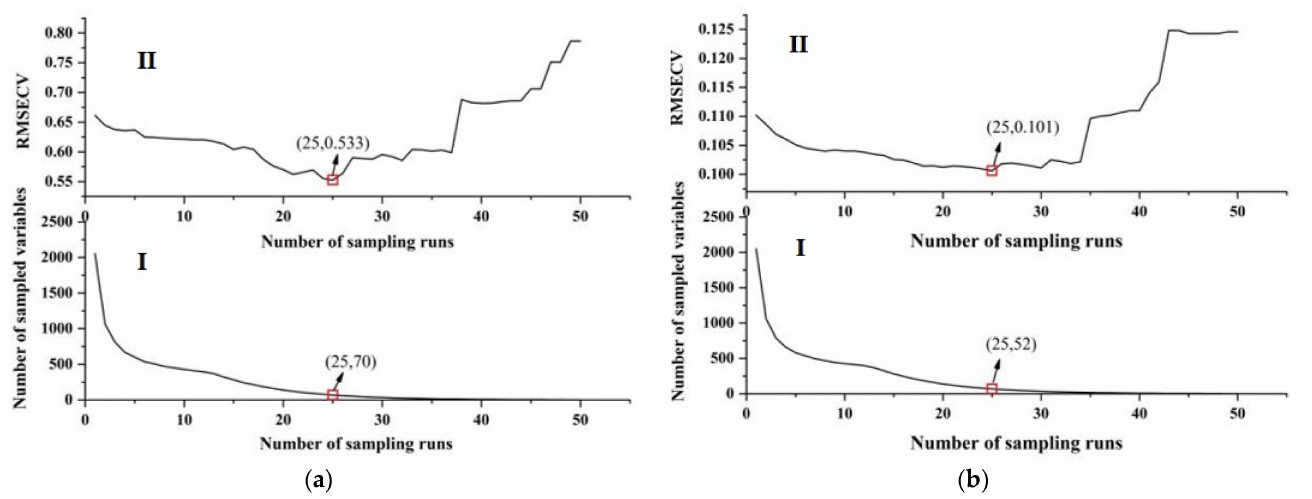
Figure 6. Trends in the number of characteristic wavelengths ( I ) and RMSECV values ( II ) of the soluble solids content (SSC) ( a ) and acidity (pH) ( b ) of pear with increasing number of CARS